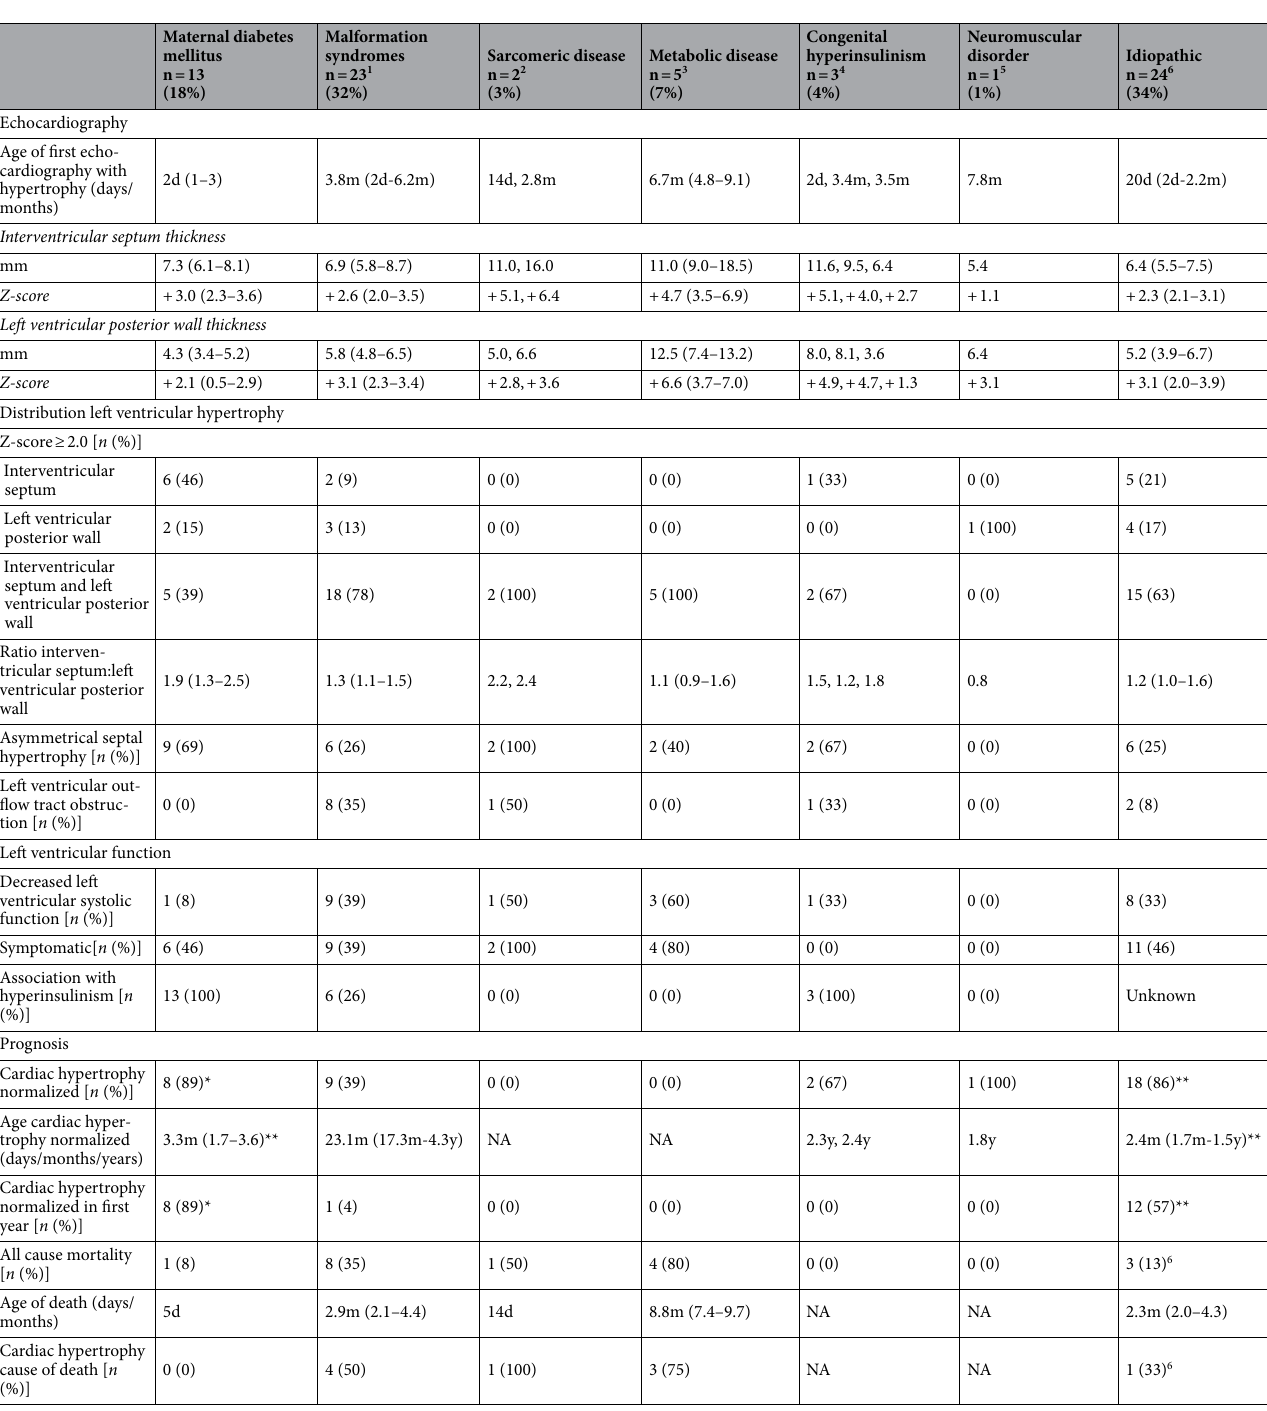
Table 2. Etiologies of cardiac hypertrophy in infants. Data are presented as median with quartiles 25–75. Where appropriate, values are presented as number of patients with percentages. 1 Noonan (n = 12), Cantu (n = 3), Costello (n = 2), Berardinelli-Seip Congenital Lipodystrophy (n = 2), 1P36 chromosomal deletion (n = 1), Trisomy 18 (n = 1), Leprechaunism (n = 1), Beckwith-Wiedemann (n = 1); 2 Mutations